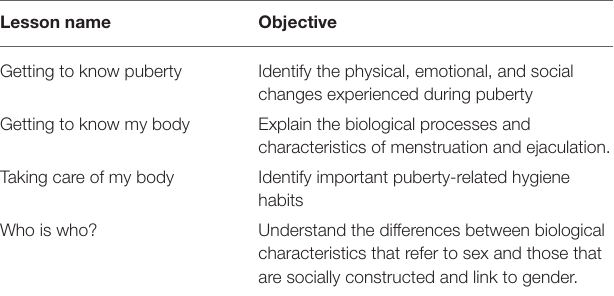
TABLE 1 | Session objectives of puberty and menstruation lesson plans. Lesson